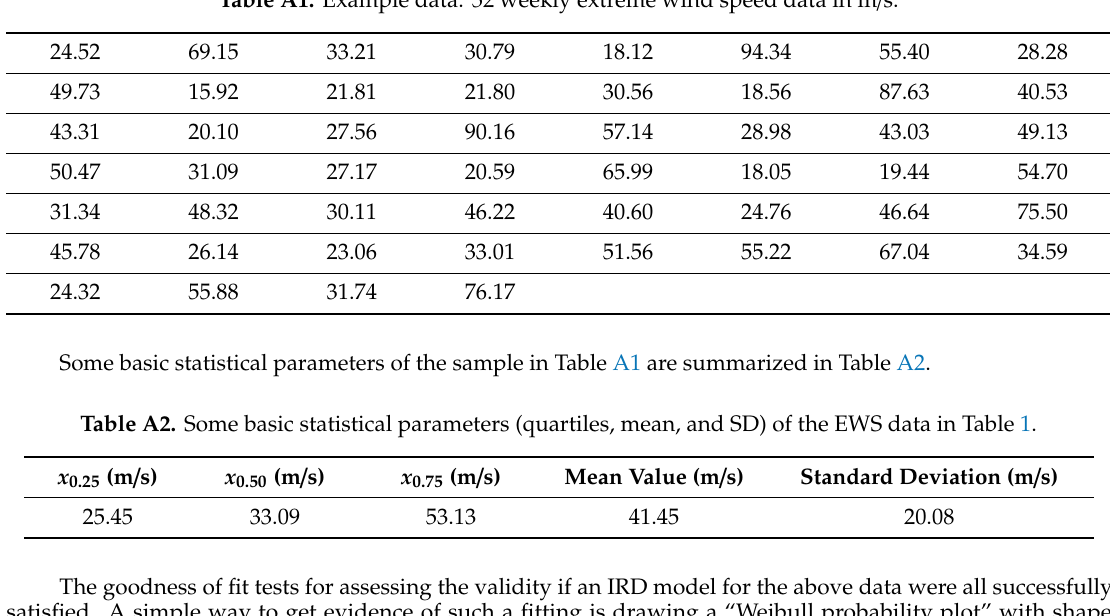
Table A1. Example data: 52 weekly extreme wind speed data in m / s.